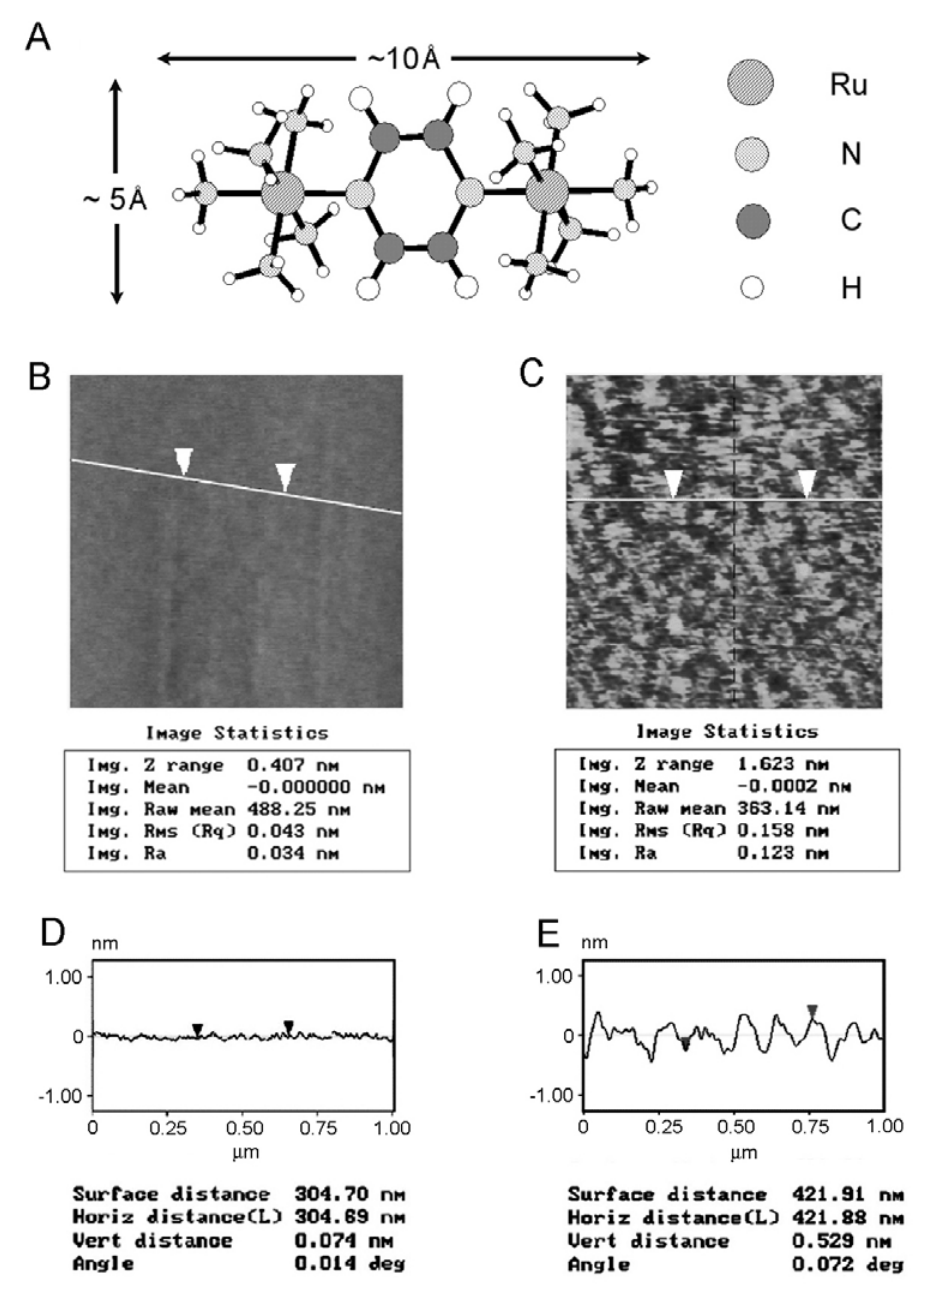
Figure 10. (A) Schematic structure of the Creutz-Taube ion with its lateral dimension illustrated. (B, C) AFM images of the SiO substrate before and after attachment of the 2 Creutz-Taube ions. Increased RMS surface roughness (0.043 nm before attachment and 0.158 nm after attachment) is observed. Line-section analysis lines are also shown on the graphs. (C, D) Line-section analysis results of (B,